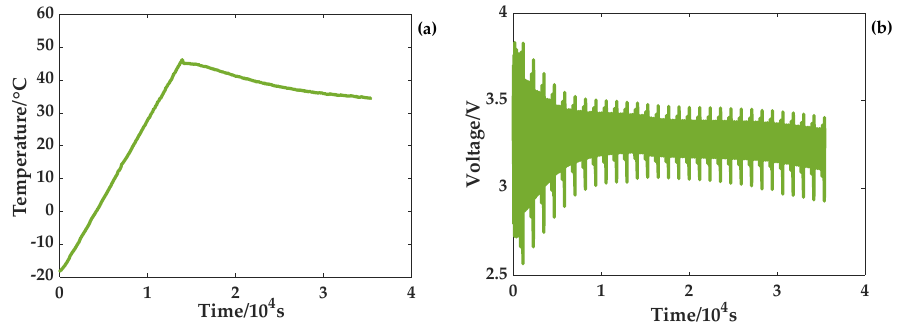
Figure 5. Temperature variation and voltage curve from the temperature rise experiment. ( a ) Temperature curve and ( b ) voltage curve.